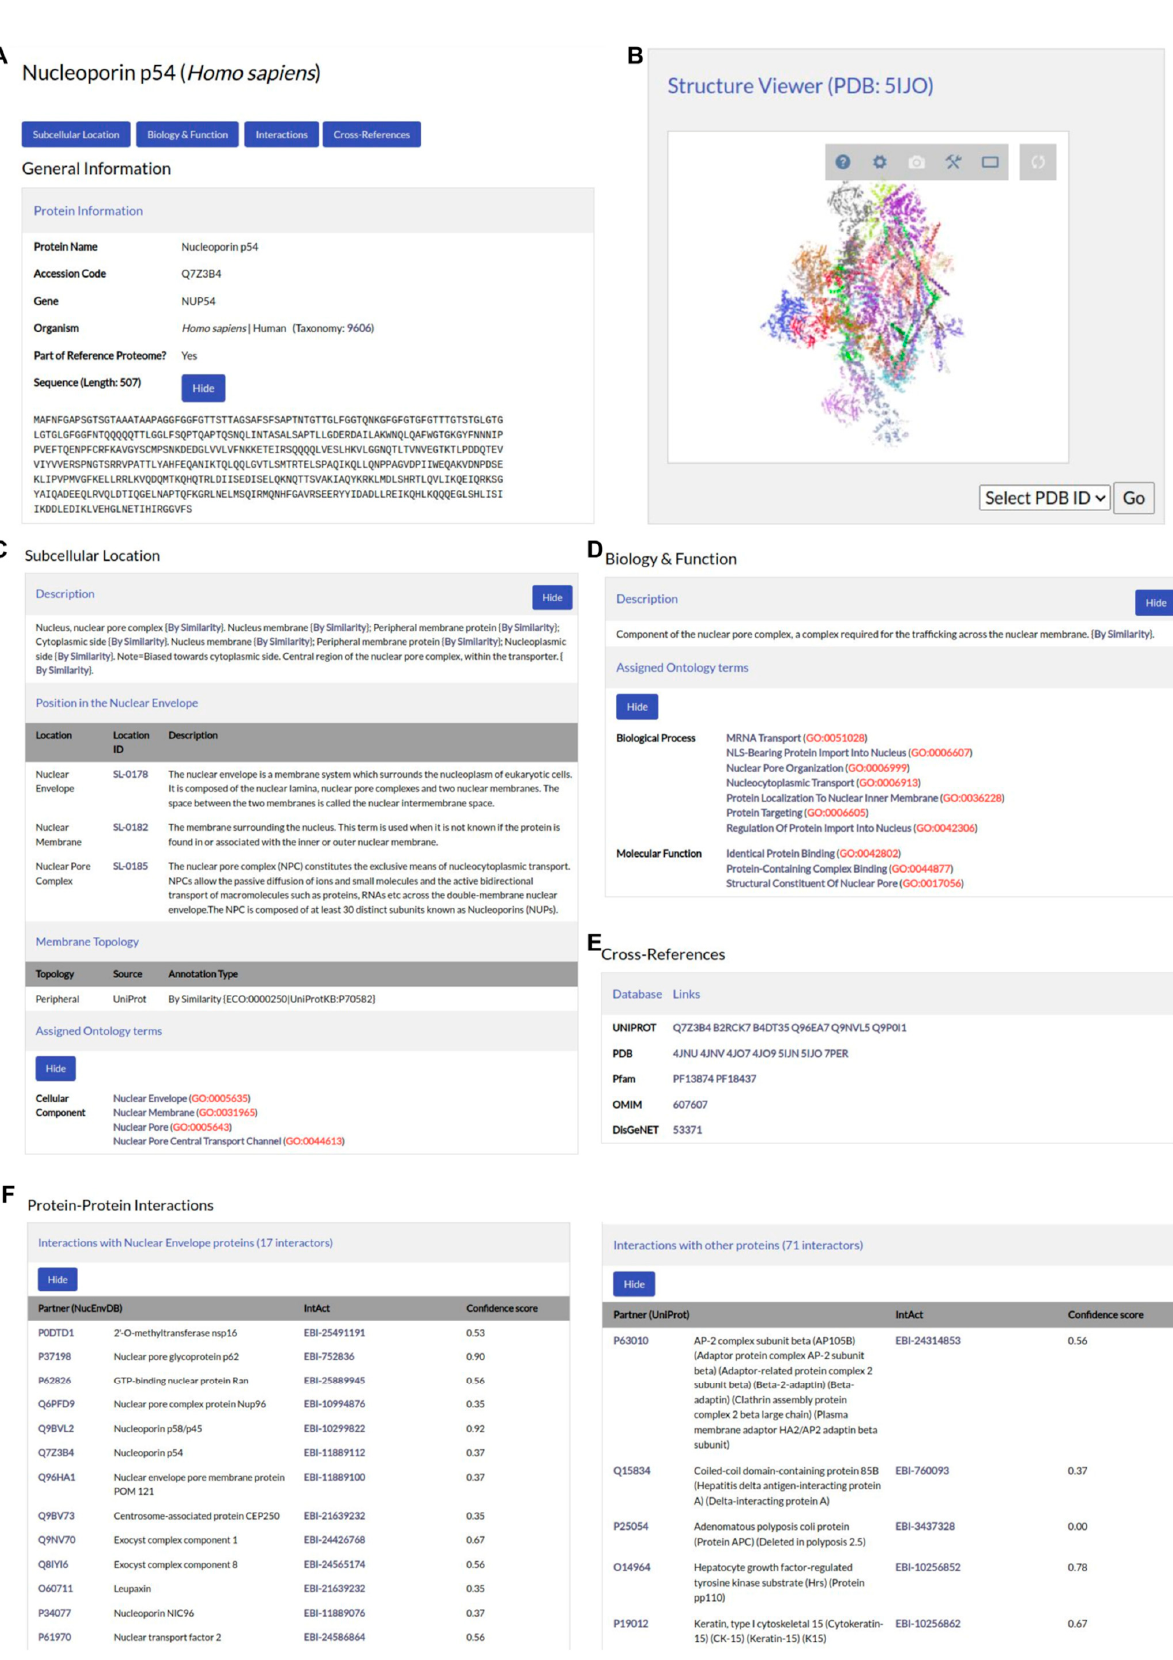
Figure 2. An example NucEnvDB entry. The human Nucleoporin p54 (AC: Q7Z3B4) is shown. ( A ) General protein information. ( B ) Structure viewer, showing the protein’s available 3D